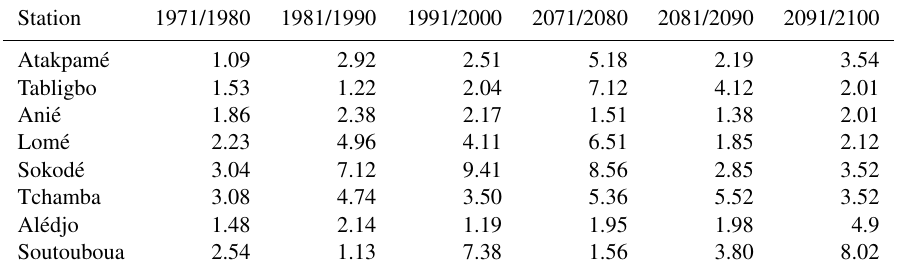
Table 4. Results obtained by calculation of the K 2 coefficient of inter-annual rainfall irregularity in the form of table of 1971–2000 and 2071–2100 for the Tabligbo, Atakpamé, Anié, Soutouboua, Sokodé, Tchamba , Alédjo and Lomé